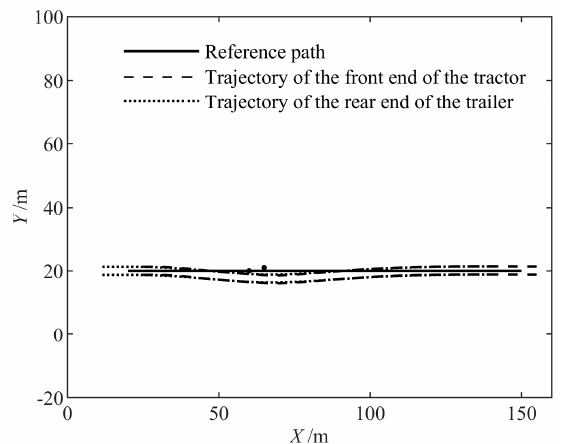
Figure 23. The trajectory of the obstacle avoidance controller based on the line model in the third group of simulations.